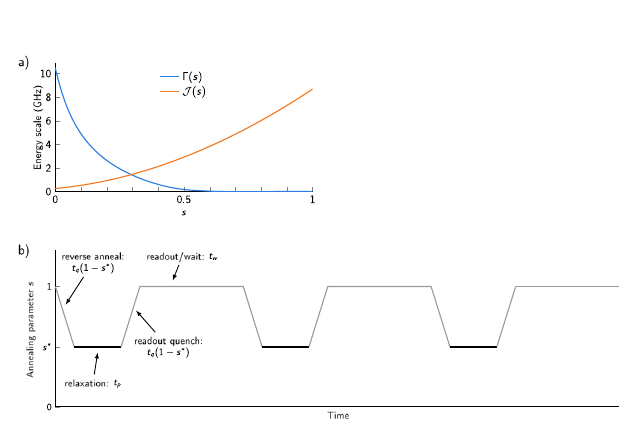
Fig. 5 | Quantum annealing schedule and protocol. a Transverse fi eld Γ ( s ) and Ising energy scale J ð s Þ as a function of annealing parameter s . Note that the total coupling between two three-qubit chains is 1 : 8 J . b Quantum evolution Monte Carlo method. A sequence of classical readout states is generated by repeated exposure to quantum fl uctuations and thermal fl